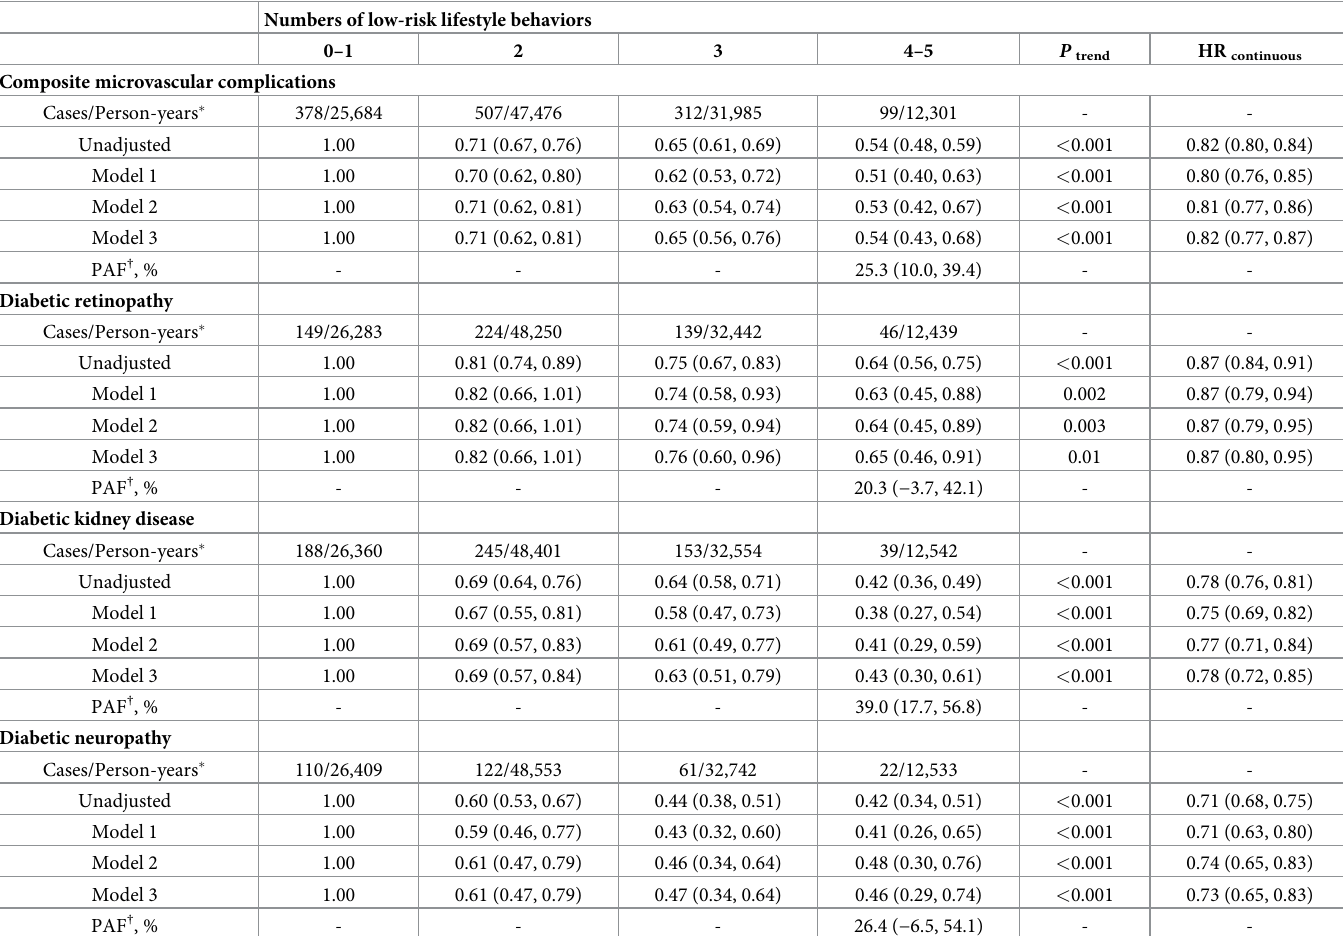
Table 2. HRs (95% CIs) of microvascular complications according to the overall lifestyle behaviors among individuals with T2D. Numbers of low-risk lifestyle